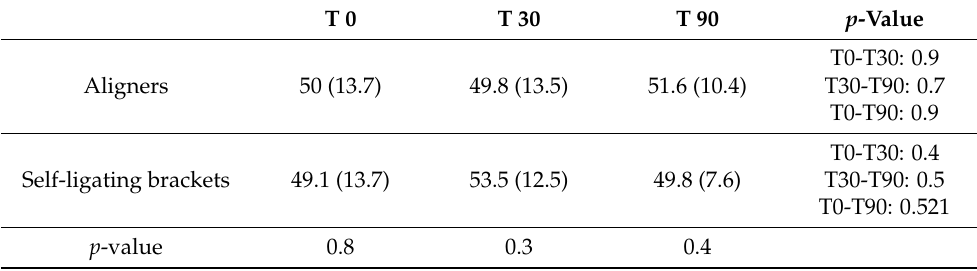
Table 4. Mean TAC values (SD) ( µ M) for the two techniques during the 90-day study